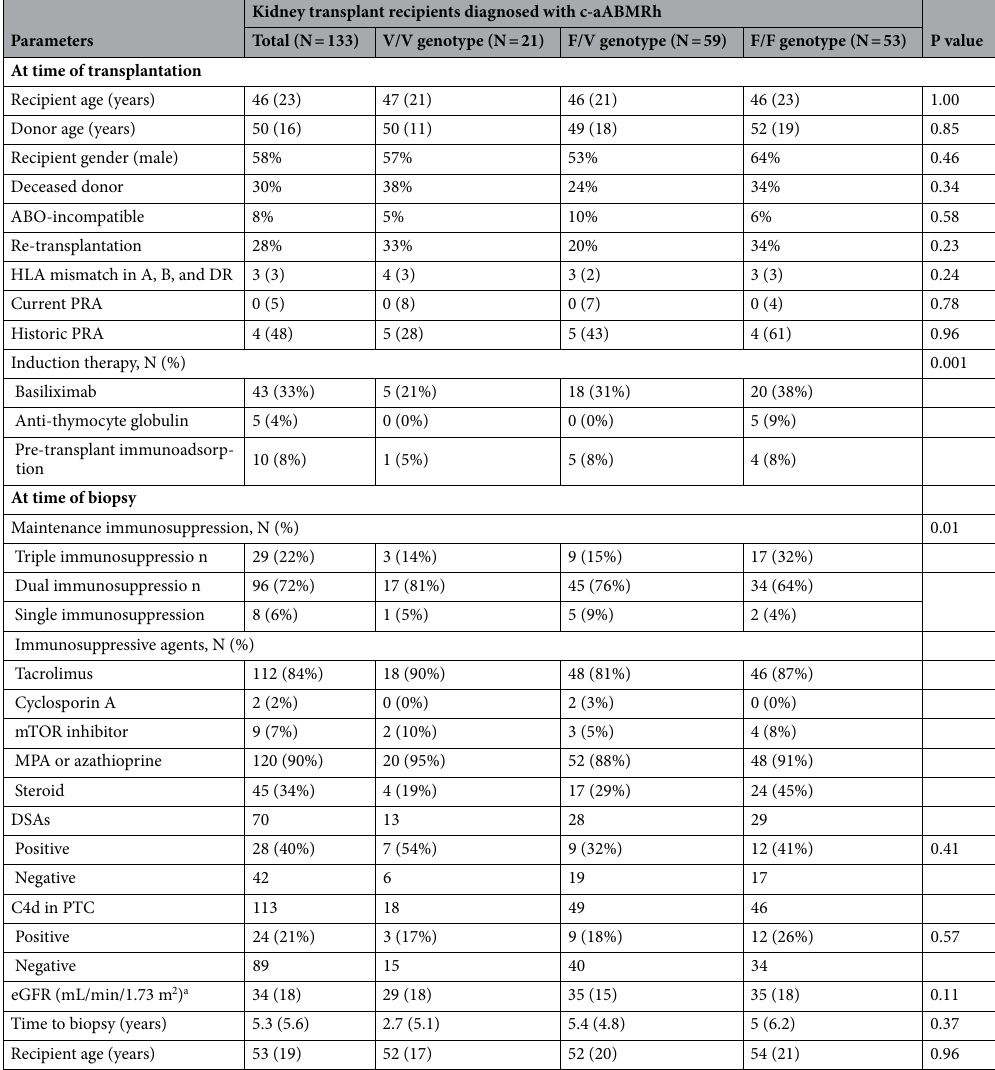
Table 1. Demographic and patient characteristics at baseline and time of diagnosis of c-aABMRh. Data represent median (IQR) and number (proportion of total), respectively. a Estimated glomerular filtration rate (eGFR): calculated using the CKD-EPI formula, multiplied by 1.159 when a patient has the African/Caribbean ethnicity.